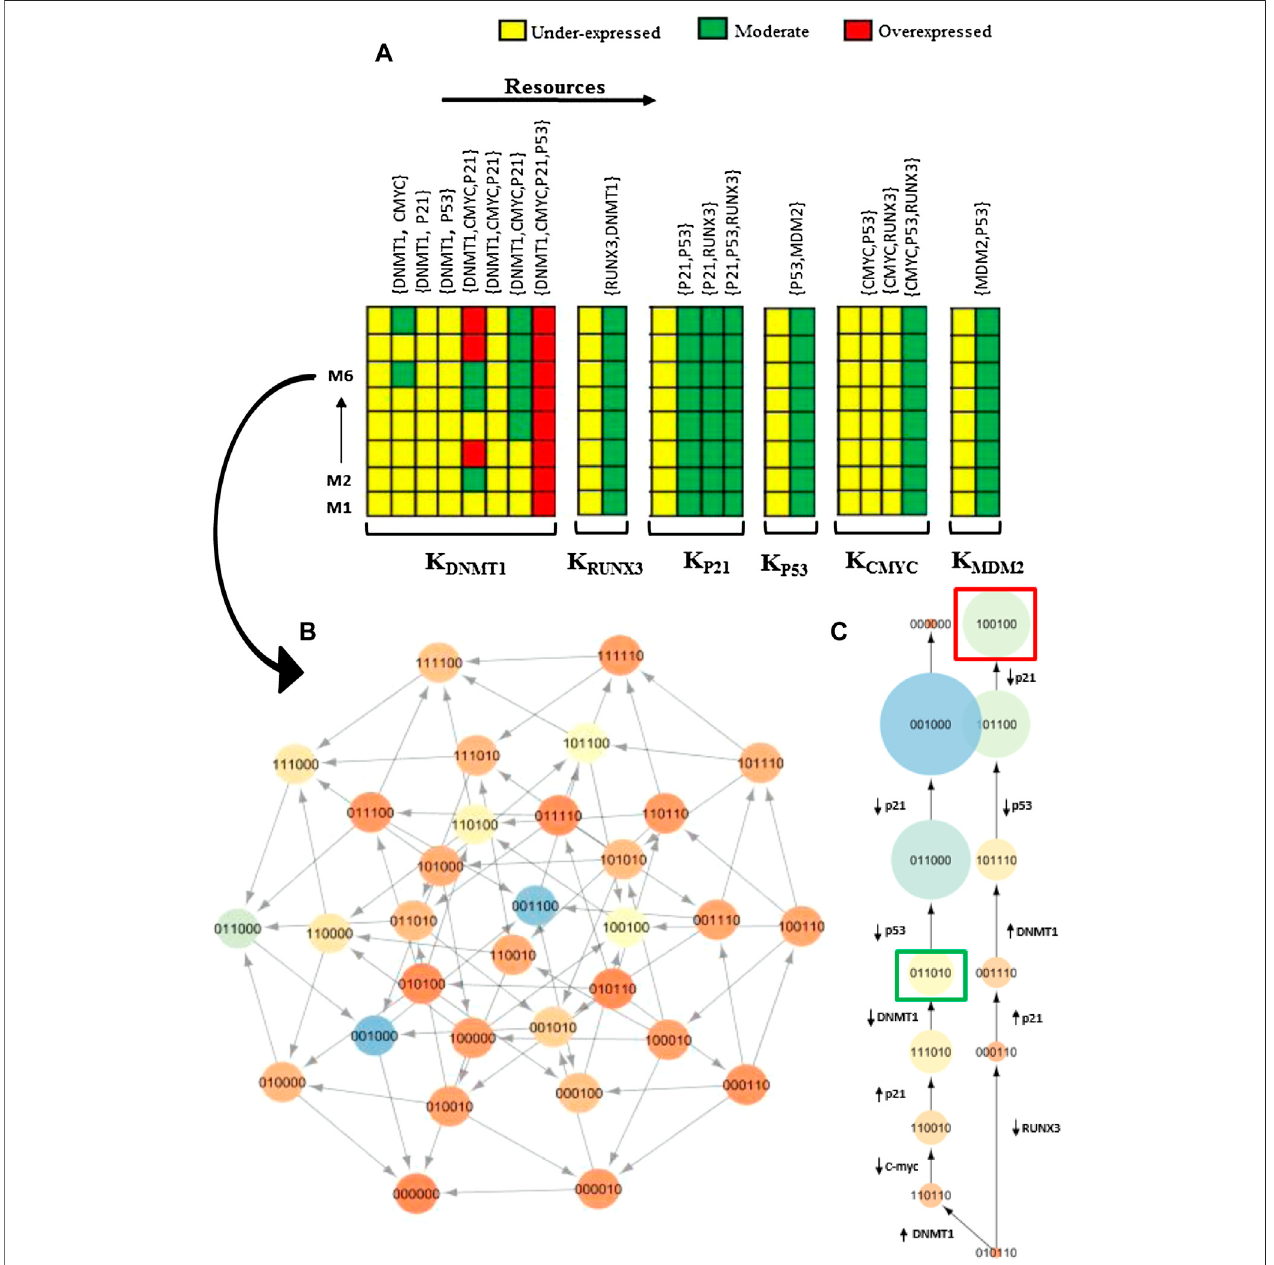
FIGURE 6 | (A) Heat map of the fi rst 8 sets of parameters out of total 14 (refer Figure 4 ) computed by SMBioNet is displayed, whereas Model 6 (M6) parameters wereusedtogeneratethestatetransitiongraphfornetworkanalysis. (B) StategraphofM6isshown,whichcomposedof32nodesand79edgessortedonthebasisof betweenness centrality. Each circle represents a unique state with gene expression in the order as follows: DNMT1, RUNX3 , p21, c-myc, p53, and MDM2. The generated state transition graph illustrates all the possible qualitative states of the system. Trajectories of the graph were then further analyzed to identify important genetic evolution. (C) A bifurcation state is highlighted characterized by the qualitative state (010110). Trajectories display distinct paths from one common transition state characterized by the onset of oncogene c-myc leading to homeostasis or pathological loop based on successive genetic changes. From the bifurcating (0,1,0,1,1,0)state,therepressed RUNX3 (0,0,0,1,1,0)convergesthesystemtowardpathologicalstatewithasuccessiveonsetofDNMT1(1,0,1,1,1,0)andoffsetofp53 (1,0,0,1,0,0).Here,thequalitativestate(1,0,0,1,0,0)ischaracterizedaspathologicalstate(highlightedinredboxintherighttrajectory)experiencedbythesystemdueto theconsistentonsetofoncogenec-mycalongwithpersistentsuppressionof RUNX3 .Onthecontrary,thesystemmightevolvetowardnormalstate(highlightedingreen box in the left trajectory) if TSG RUNX3 gets activated causing constant inhibition of oncogene c-myc (1,1,0,0,1,0), to control the moderate expression level of DNMT1 (0,1,1,0,1,0). The normal state is characterized by the activation of RUNX3 along with the controlled expression level of DNMT1 (0,1,1,0,1,0), which is achieved by the system through continuous activation of TSG RUNX3 along with the consistent inhibition of oncogene c-myc, ultimately leading to a typical reset state (0,0,0,0,0,0).